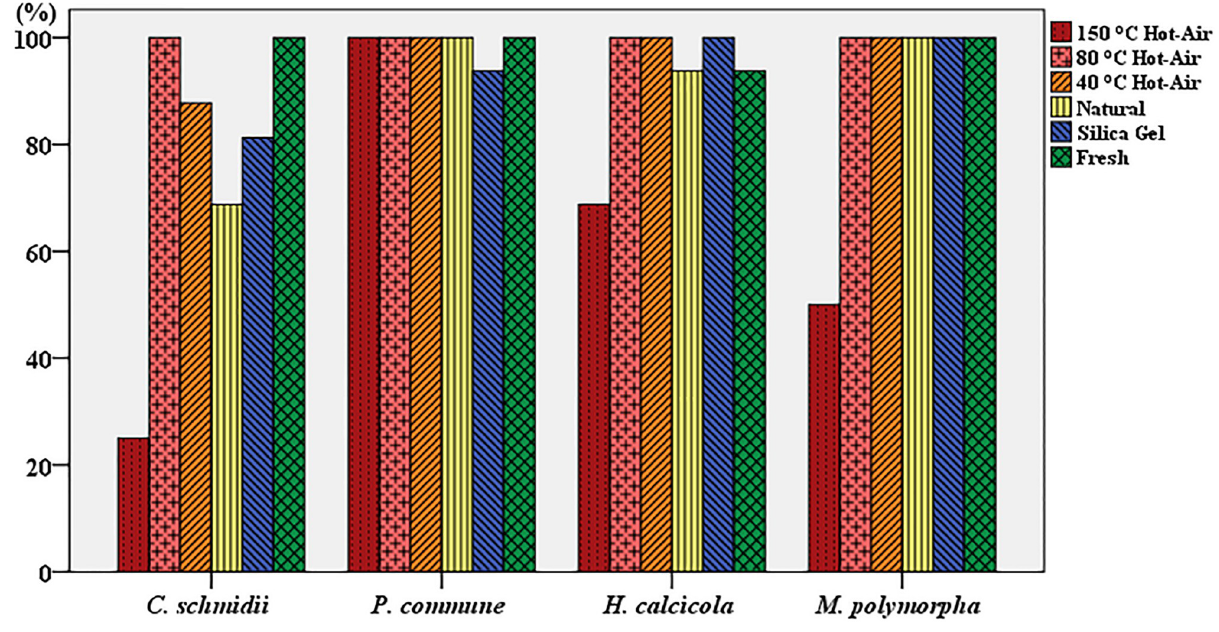
Fig 4. Success rates of PCR